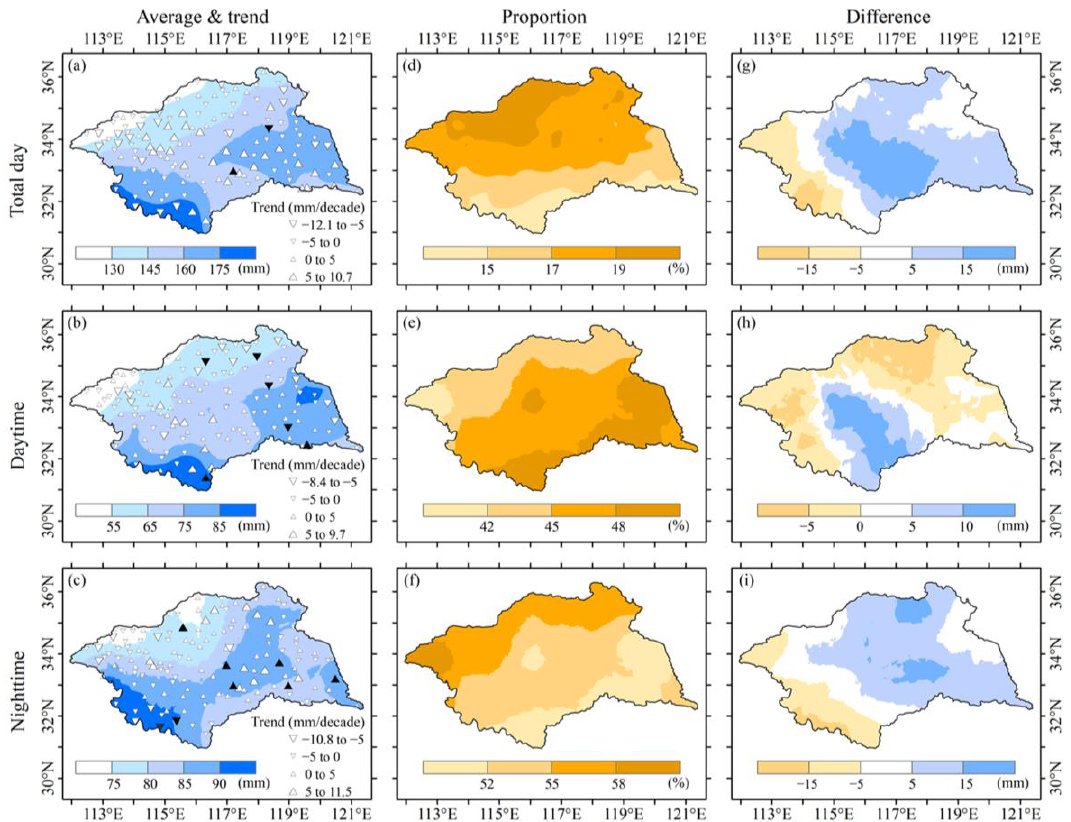
Figure 11. ( a ) Climatology of RX5day and trend characteristics, ( b , c ) the spatial patterns of daytime and nighttime precipitation under RX5day conditions. ( d ) The RX5day proportion of the annual total precipitation, and ( e , f ) the proportions of daytime and nighttime precipitation under RX5day conditions. ( g ) The mean differences between RX5day values in the two equal periods (1990–2018 minus 1961–1989), and ( h , i ) the mean differences between the two equal periods (1990–2018 minus 1961–1989) in the daytime and nighttime precipitation under RX5day conditions. Upward and downward triangles denote increase and decrease trends, respectively; solid triangles represent linear trends at the p < 0.05 significance